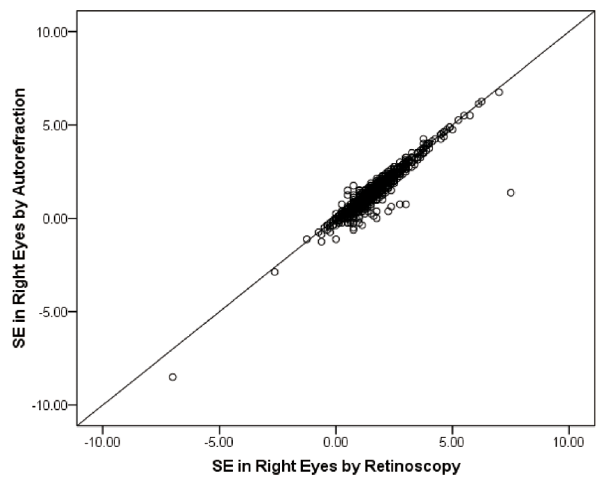
Figure 1. Comparison of refractions measured by autorefrac- tion and retinoscopy in right eyes.